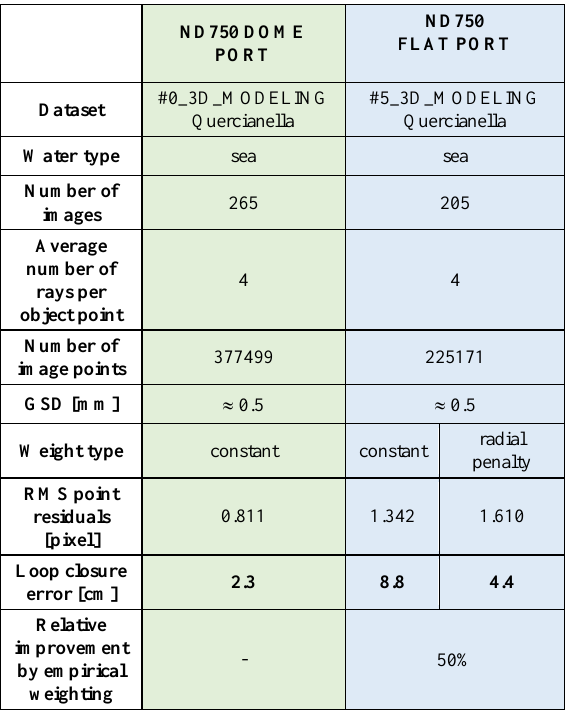
Table 2. Summary of the results for the dataset of the semi- submerged industrial structure located in the Bay of Rogiolo, near Livorno,